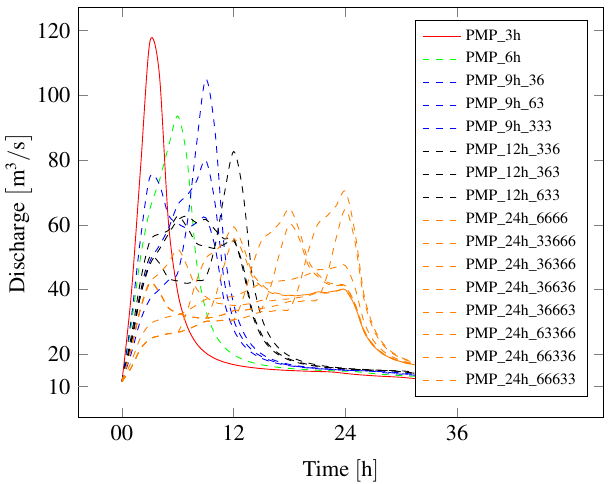
Figure 10. PMF estimations for different durations of PMP with different spatio-temporal rainfall structures. The legend of the graph indicates the composition of the structure by shorter rainfall events (PMP_9h_36 is a 9h PMP composed by a 3 and 6h PMP